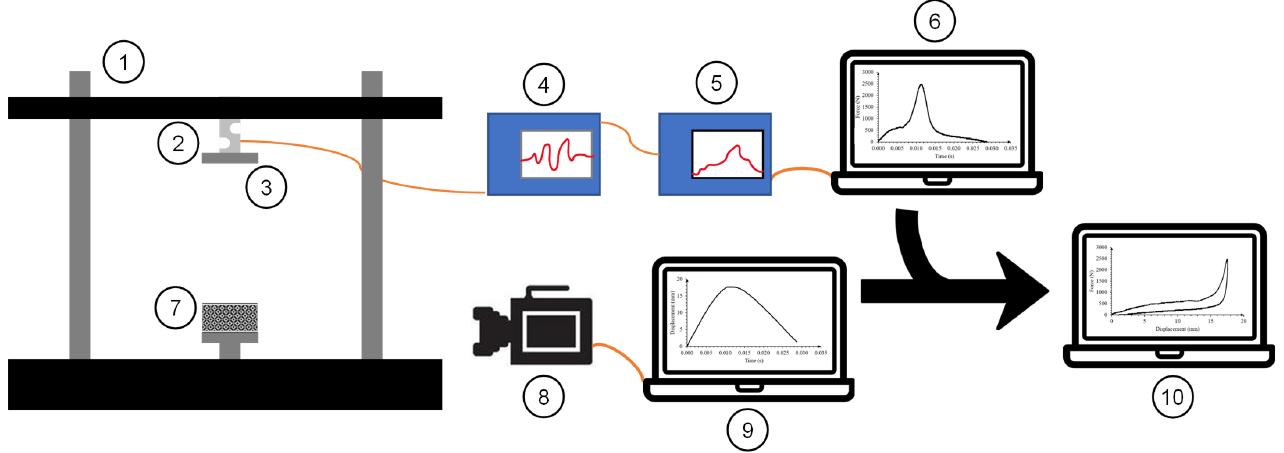
Figure 2. Scheme and data procedure for dynamic compression tests: (1) Drop tower; (2) Load cell; (3) Impactor; (4) Amplifier; (5) Oscilloscope; (6) Force ‐ time data from the load cell; (7) Lattice sample; (8) High ‐ speed camera; (9) Displacement ‐ time data from high ‐ speed video; and (10) Force ‐ displacement compiled data.